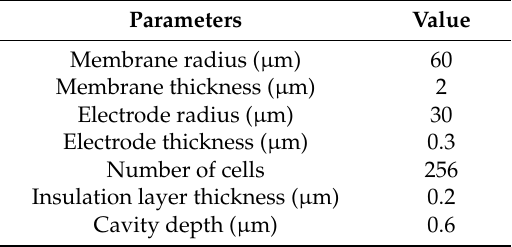
Table 1. The parameters of the designed capacitive micromachined ultrasonic transducer (CMUT)